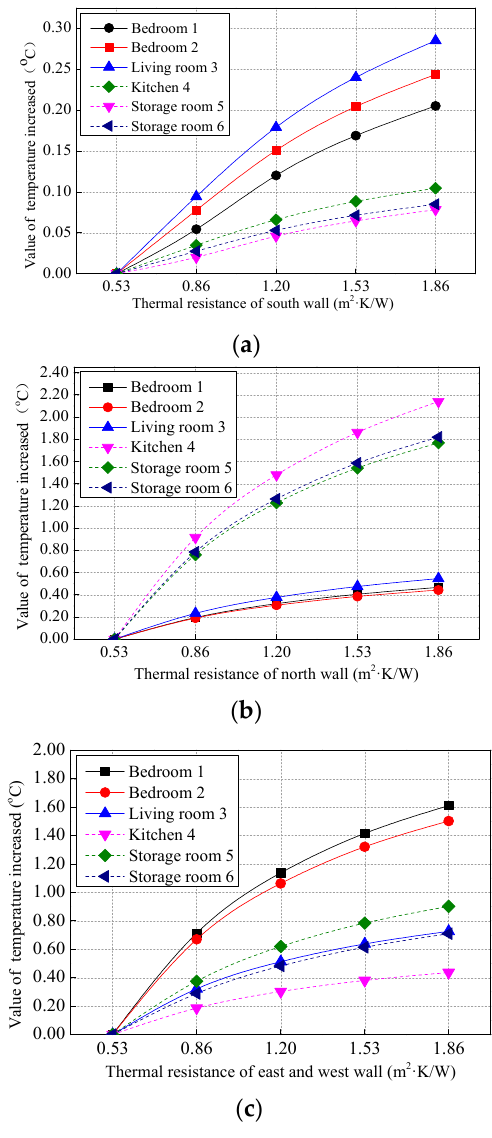
Figure 12. Indoor air temperature increases with the increase of exterior walls thermal resistance. ( a ) South wall; ( b ) north wall; ( c ) east/west wall. ( a ) South wall; ( b ) north wall; ( c ) east / west